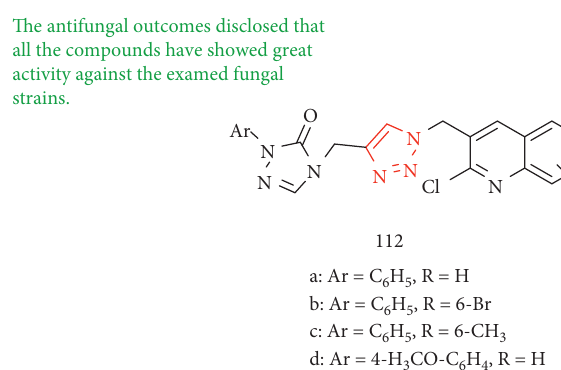
Figure 51: The chemical structure of quinoline-appended triazoles as potent antitubercular and antifungal agents.